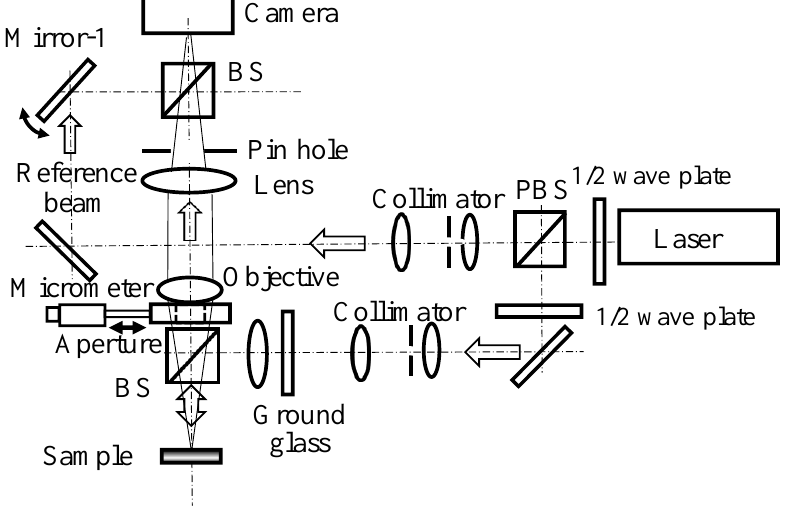
Figure 2. Optical system.